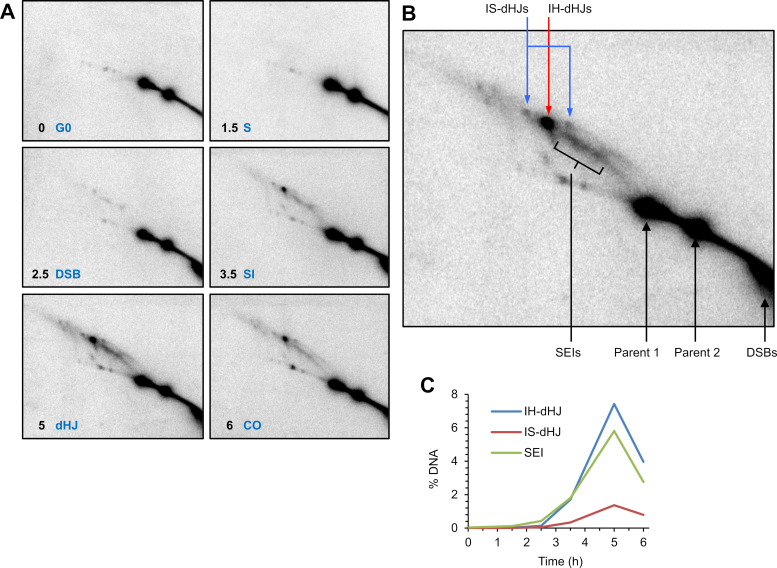
Two-dimensional Southern blot analysis of joint-molecule recombination intermediates.(A) 2D gels Southern images representative of each timepoint collected for proteomics analysis. G0, G0 phase before cells enter meiosis; S, S-phase; DSB, initiation of recombination via DNA double-stranded break formation; SI, strand invasion and ongoing homolog synapsis; dHJ, double-Holliday junction formation and full synapsis; CO, crossover formation and desynapsis. (B) Single panel highlighting specific recombination intermediates. IH-dHJ, inter-homolog double-Holliday junction; IS-dHJ, inter-sister double-Holliday junction; SEI, single-end invasion; DSB, double-strand break. (C) Quantification of SEIs and dHJs over the entire meiotic time course.